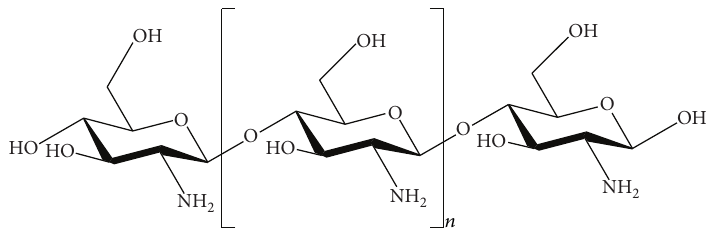
Figure 2: Chemical structure of the chitosan